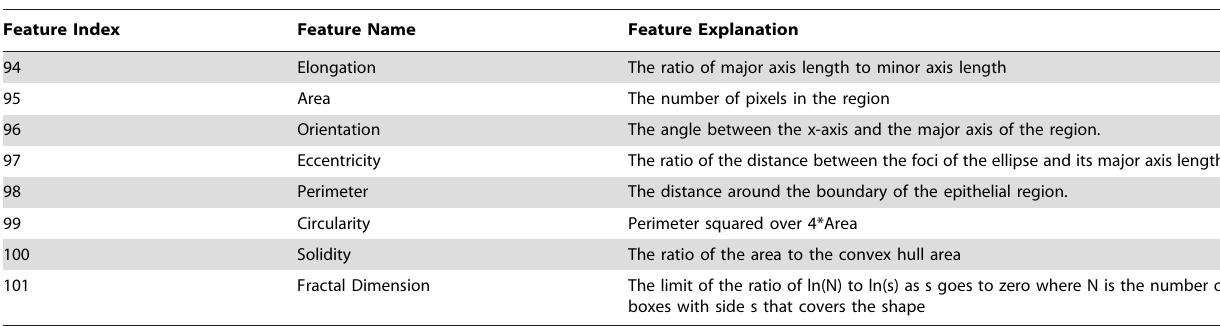
Table 4. Morphological (shape based) features.